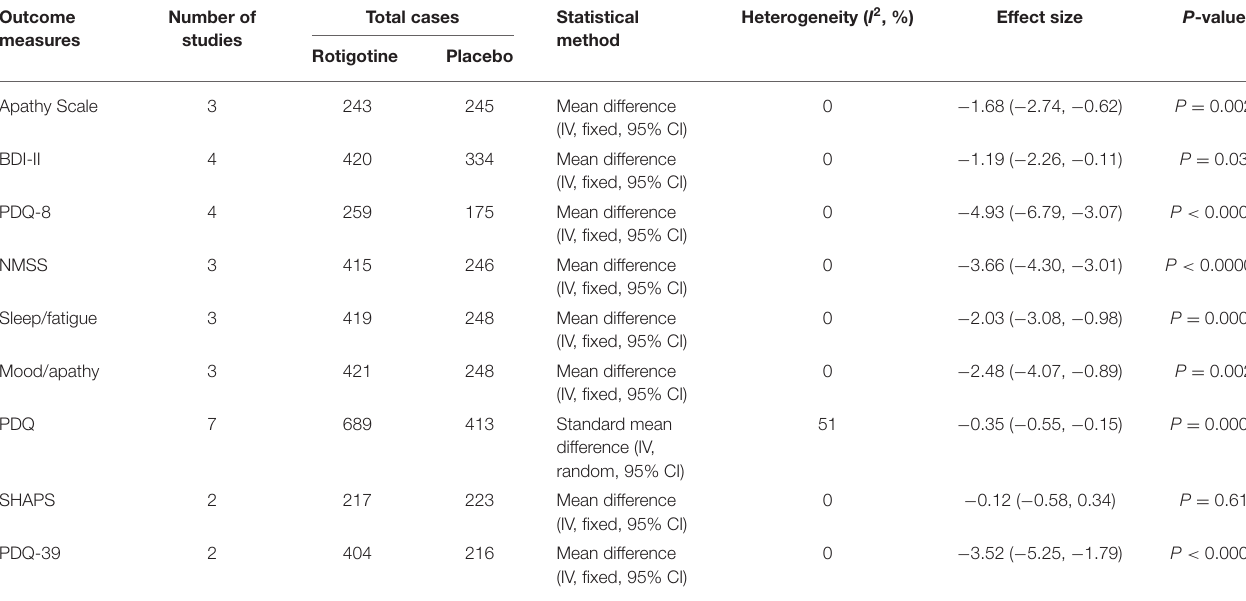
TABLE 3 | Effect of rotigotine vs. placebo on neuropsychiatric symptoms of Parkinson’s disease. Outcome